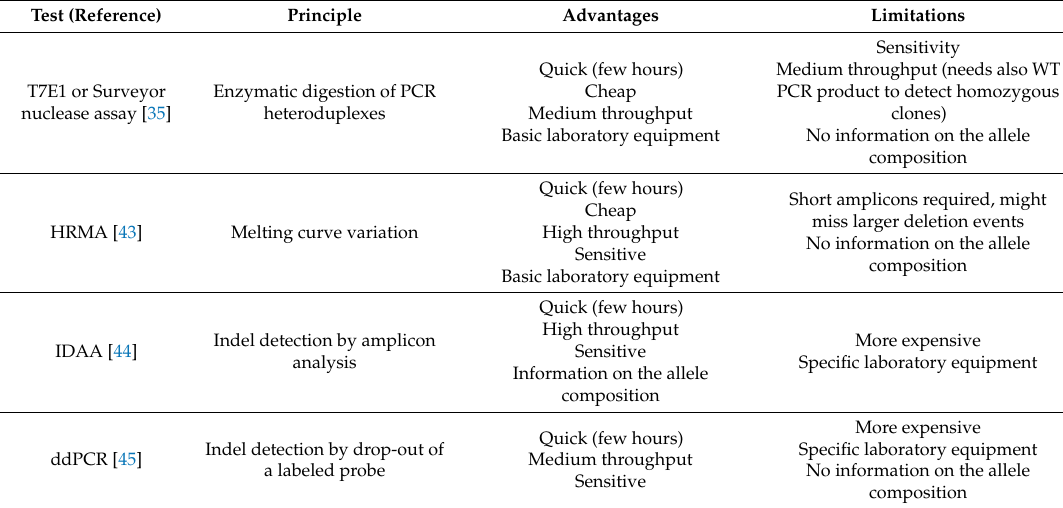
Table 1. Advantages and limitations of the indel screening